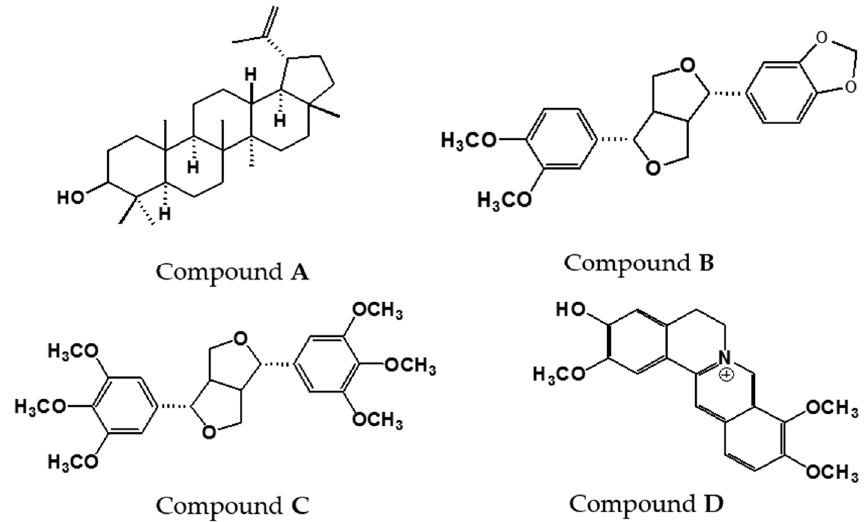
Figure 2. Structures of compounds isolated from the chloroform fraction of Z. rhetsa bark.